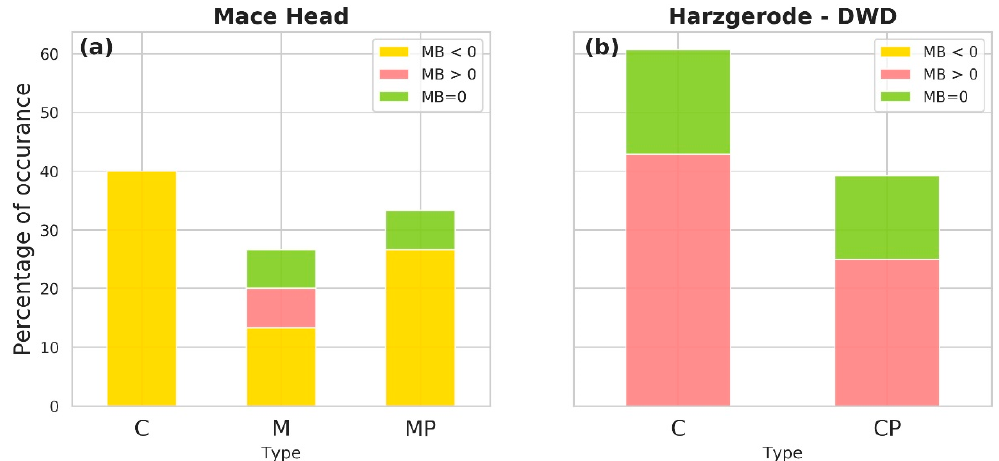
Figure 10. Occurrence (%) of different MB values per different types of ambient air samples for ( a ) the 15 Mace Head and ( b ) the 28 Harzgerode cases. The classification of the ambient air samples types is made with HYSPLIT, and for the purposes of this study, it is as follows: Pure marine (M), marine polluted (Mp), pure continental (C), and continental polluted (CP). A more detailed explanation is given in Section 4.